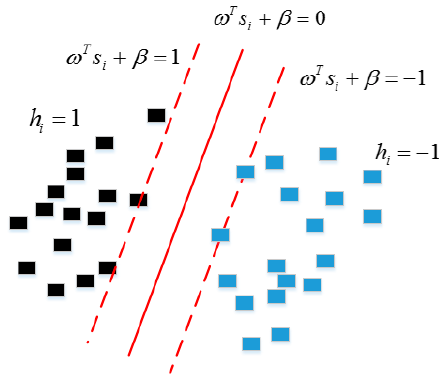
Figure 4. SVM classification theory.